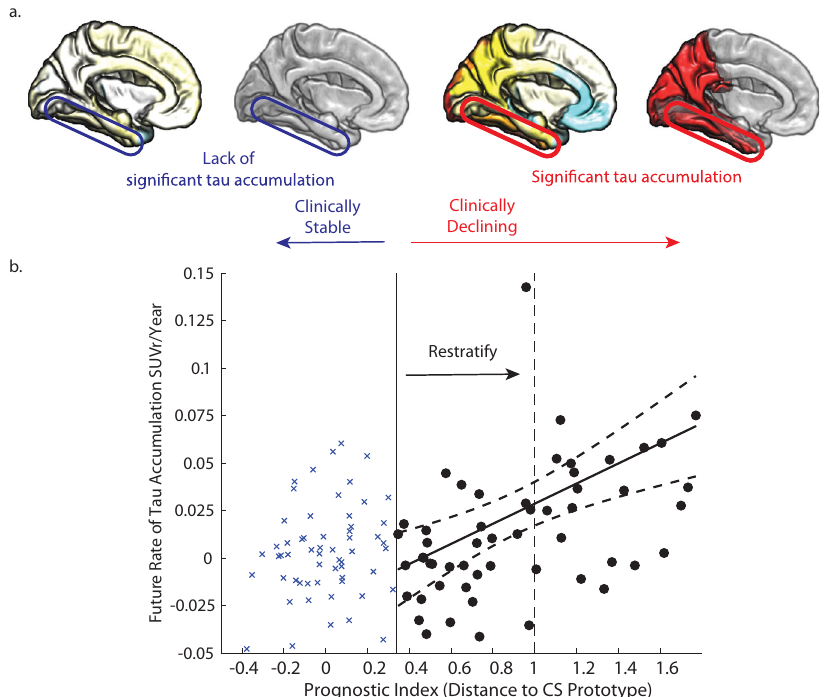
Fig. 8 Potential application in clinical trial design. a Cortical maps show average rate of tau accumulation for individuals classi fi ed as Clinically Stable vs. Clinically Declining (see Fig. 4). b Relationship of the scalar projection with future rate of tau accumulation within the Fusiform gyrus (as shown in Fig. 6a). The solid black vertical line indicates the probabilistic boundary used to perform the binary strati fi cation, blue crosses indicate rate of tau accumulation for the clinically stable group, black circles indicate future rate of tau accumulation for the clinically declining group. Using our prognostic index (i.e., scalar projection) we show that re-stratifying to a more stringent threshold — as indicated by the dashed black vertical line — a new sample can be selected with higher future rates of tau accumulation and lower heterogeneity within the